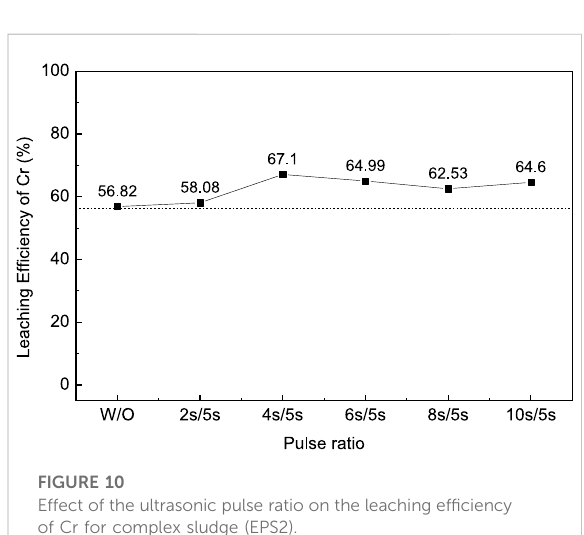
FIGURE 10 Effect of the ultrasonic pulse ratio on the leaching ef fi ciency of Cr for complex sludge